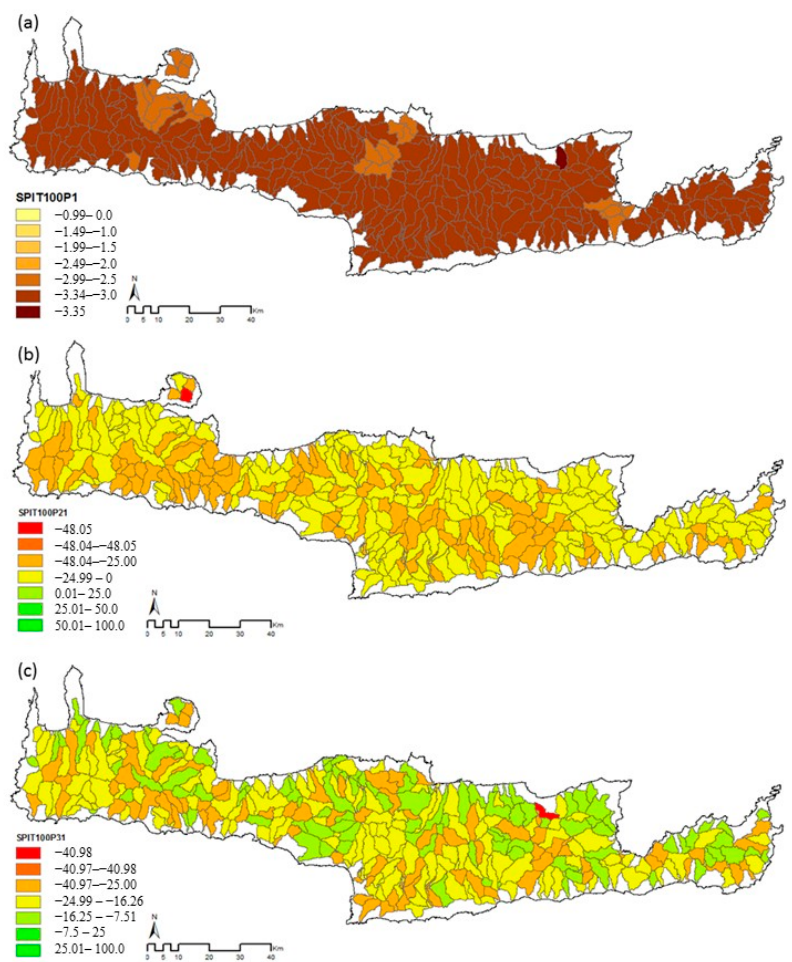
Figure 5. Meteorological frequency analysis under climate change using GEV for T = 100 years return period and for study periods ( a ) 1985–2010 (baseline period), ( b ) 2025–2050 (relative percentage change), ( c ) 2075–2100 (relative percentage change).